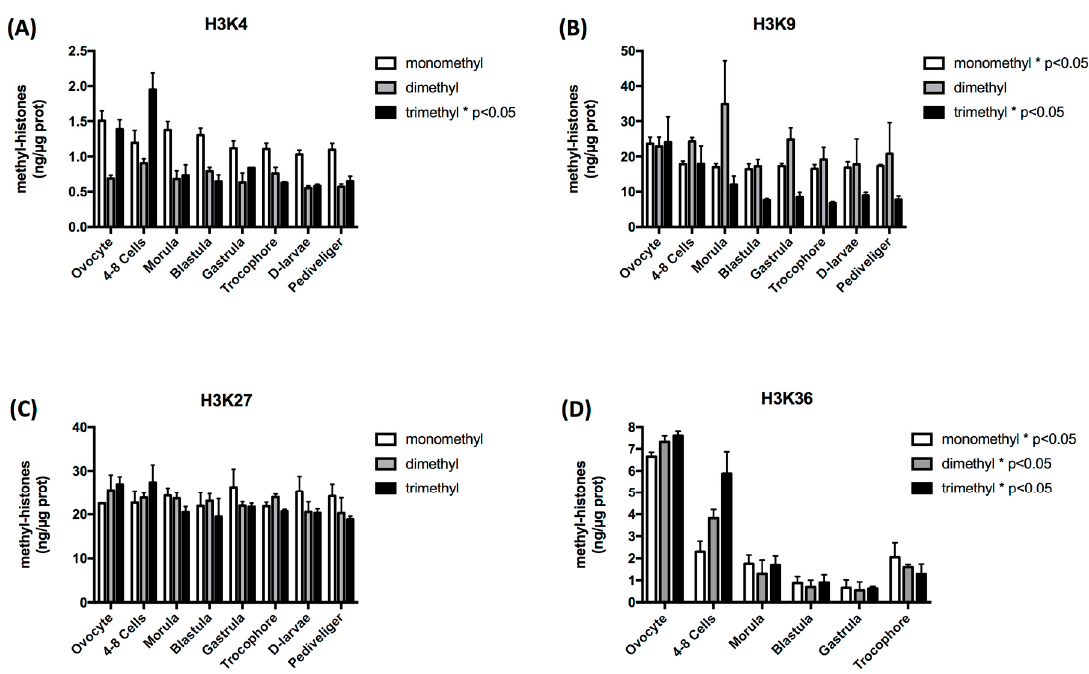
Figure 1. Histone methylation profiles of H3K4 ( A ), H3K9 ( B ), H3K27 ( C ) and H3K36 ( D ) during the early development of Crassostrea gigas . Asterisk in the legend indicates significant variation of the indicated mark along development A One-way ANOVA was used to determine whether methylation levels were statistically significantly different between development stage for each residue, and a p -value < 0.05 was considered significant.